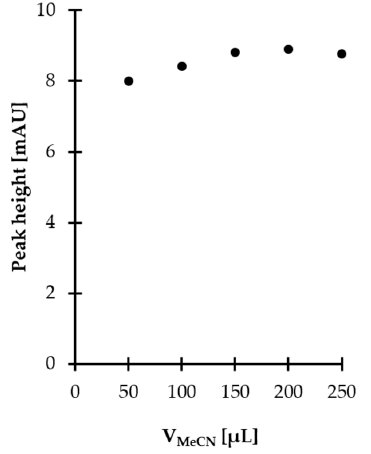
Figure 1. Influence of MeCN amount on HPPTCA release from plasma proteins, expressed as a peak height of HPPTCA. Samples were analyzed according to a previously published HPLC-UV assay [21].